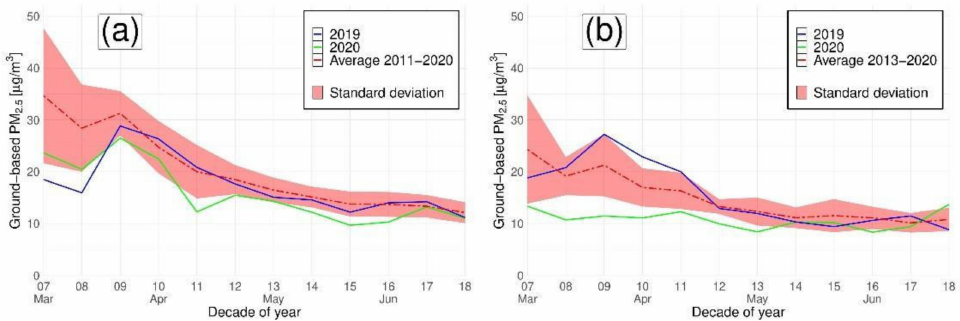
Figure 6. Mean decadal ground-based PM 2.5 concentrations ( µ g/m 3 ) from GIOS air quality stations in Poland in 2019 (blue line), 2020 (green line) and the multi-annual average (dashed red line). Standard deviations corresponding to multi-annual averages are marked in pink. Panel ( a ) depicts the average from 15 urban stations with respect to a 10-year multi-annual mean. Panel ( b ) depicts a single non-built-up station with respect to an 8-year multi-annual